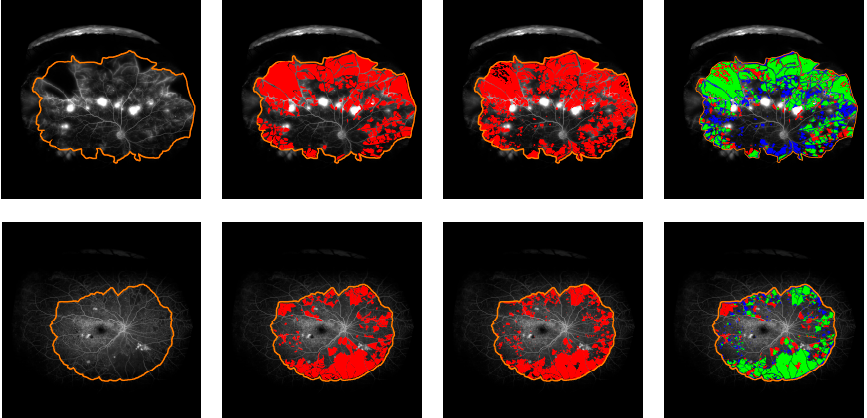
Figure 4. CNP dense segmentation examples. Time after dye injection: 53 ( top ) and 43 ( bottom ) seconds. Left to right: FA image and gradable area, manual segmentation, automatic segmentation, performance comparison (TP: green, FN: red, FP: blue).